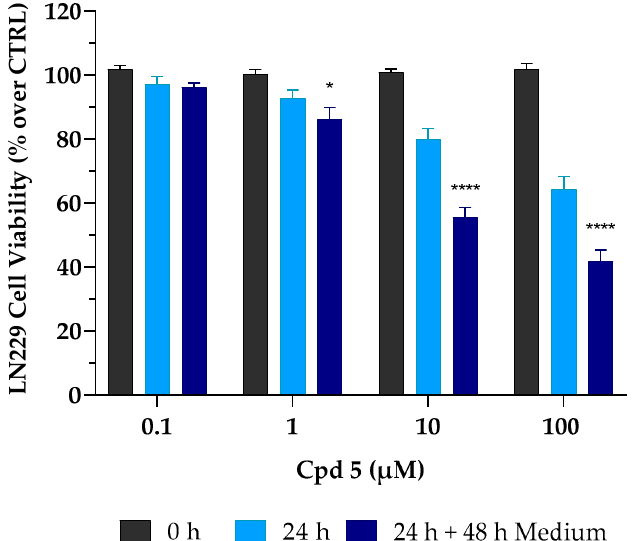
Figure 1. Irreversible cytotoxic effect of compound 5 (Cpd 5 ) on LN229 GBM cell line. These were treated with the compound for 24 h (24 h, light-blue column) and then incubated for 48 h with fresh, drug-free medium (24 h + 48 h medium, dark-blue column). Afterward, cell viability was assessed using the MTT assay. Values are the means ± SD of n = 3 independent experiments run in triplicate. * p < 0.05, **** p < 0.001 vs. 24 h at the same concentration (ANOVA followed by Tukey’s multiple comparison test).